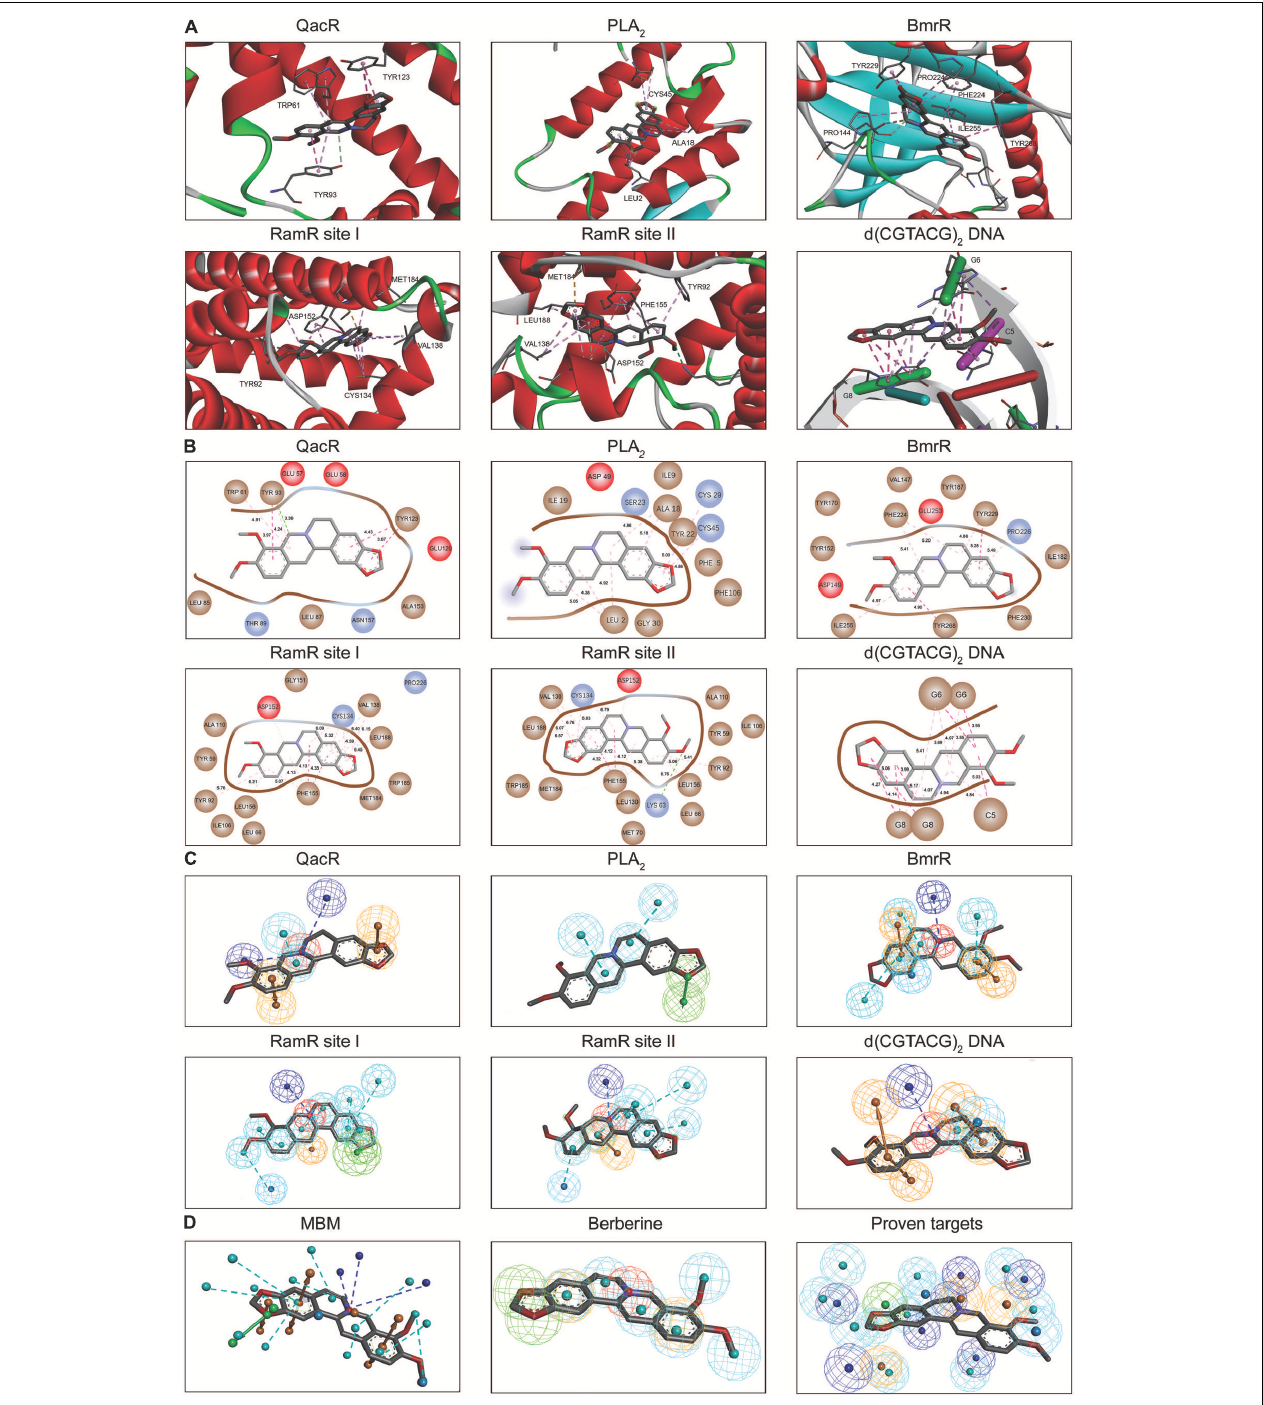
FIGURE 2 | The MBM model of berberine. The berberine and key residues are shown as sticks with carbon, oxygen and nitrogen colored gray, red, and blue. Electrostatic interactions are shown as dashed lines with π – π , π -alkyl and hydrogen bonds colored purple, pink, and green, respectively. (A) The binding motifs of berberine within QacR, PLA 2 , BmrR, RamR, and d(CGTACG) 2 DNA. Two binding sites appeared in RamR, including site I and site II. Secondary structural elements are depicted as ribbons (coils, α -helices; arrows, β -sheets). Color is based on secondary structures ( α -helices, red; β -sheets, skyblue; loops, green). (B) The molecular interactions of berberine with surrounding residues. Hydrophobic, acidic and excluded residues are colored brown, red and blue, respectively. (C) The multi-target pharmacophore models of berberine. The colored spheres identify the position and the type of binding features (aromatic rings, orange; hydrophobic portions, cyan; cations, red; anions, blue; hydrogen bond acceptors, green). (D) MBM model obtained for berberine. For clarity, the binding features are represented as circles. Color-coding is given as indicated.